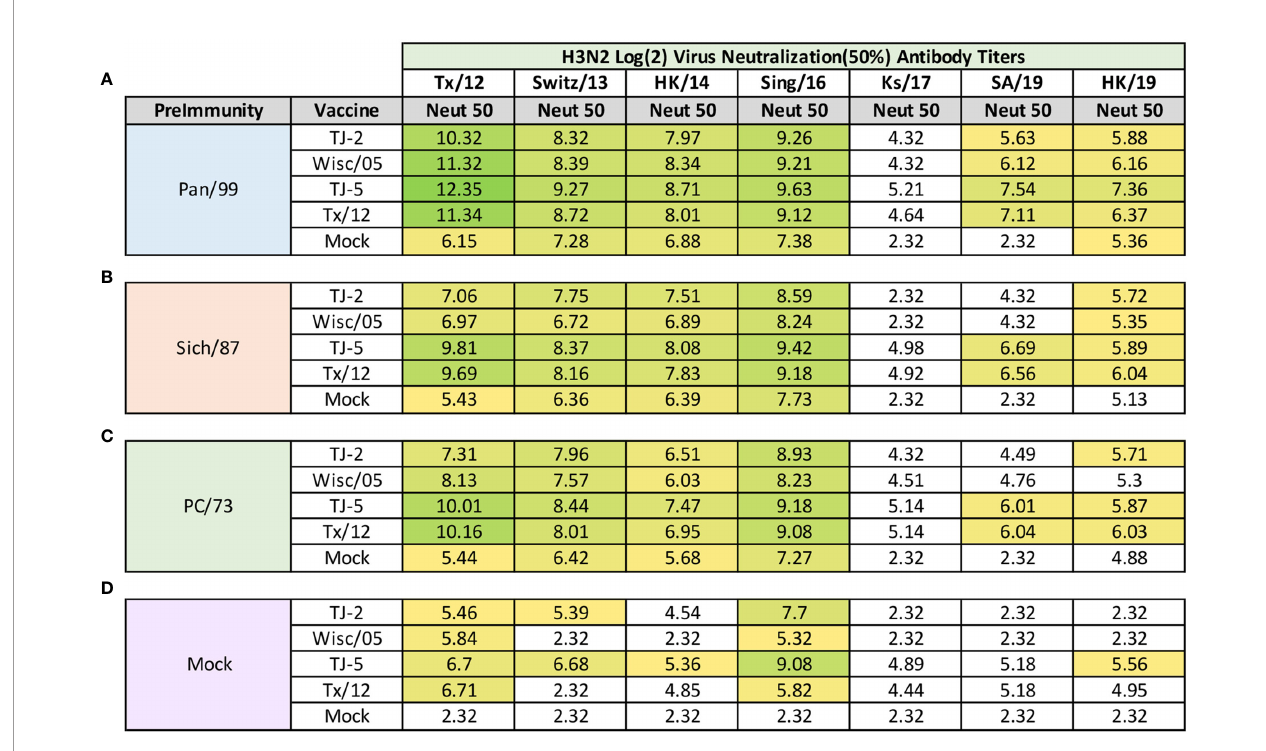
FIGURE 8 | Day 98 H3N2 Focal Reduction Assays. Serum collected from animals 98 days post infection (14 days after fi rst vaccination) was analyzed for neutralizing antibody activity against a panel of historical H3N2 in fl uenza vaccine strains spanning 2012-2019 using a focal reduction assay. Table is divided into sections based on the virus each animal received to establish preimmunity: A/Panama/2007/1999 (A) , A/Sichuan/2/1987 (B) , A/Port Chalmers/1/1973 (C) , or PBS (Mock) (D) . Cells in table are color coded as a heat map based upon Log(2) HAI geometric mean titer (GMT) where 50% virus neutralization (Neut50) was observed for each group of ferrets (N=4). The heat map colors cells yellow at Log(2) GMT of 5.32 which correspond to an antibody titer of 1:40 and cells become a darker shade of green as the average antibody titer of the group increases. Cells with no color correspond to groups that did not achieve a Neut50 GMT ≥ 5.32. The lowest serum dilution analyzed was 1:20, if no Neut50 titer was observed at this dilution a Neut50 GMT value of 2.32 which corresponds to an antibody titer of 1:5 was assigned to the